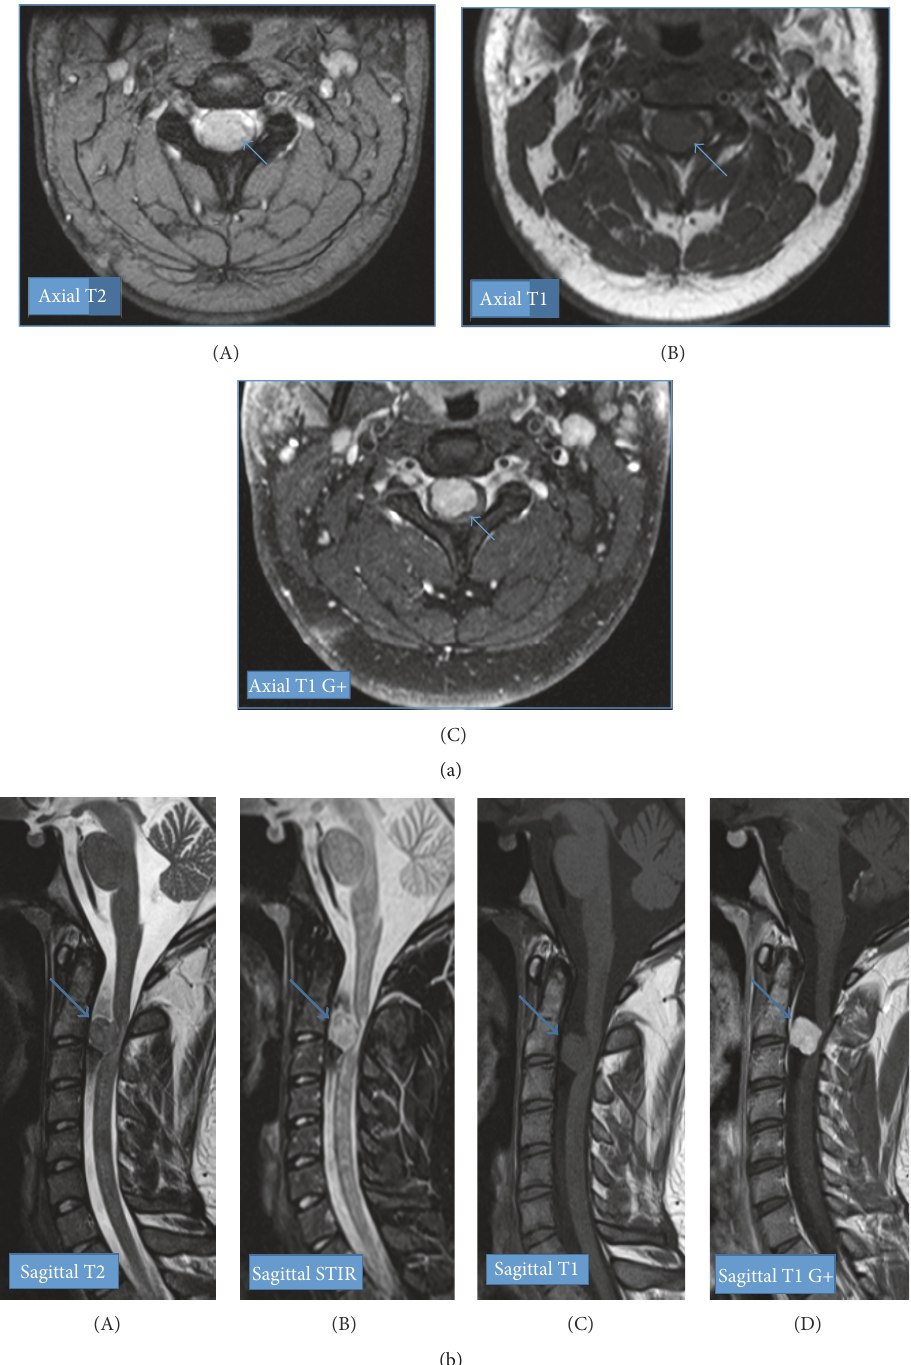
Figure 1: There is a slightly lobulated well-demarcated 1.4 × 1.7 × 1.2 cm intradural extramedullary mass lesion (blue arrow) in the spinal canal, anterior to the spinal cord at the level of C2-C3. There is mass effect with posterior displacement of the cord as well as cord edema. There is widening of the ventral subarachnoid space. It is homogeneously isointense on T1 and slightly heterogeneously hypointense on T2. Postcontrast imaging demonstrates avid diffusely homogenous